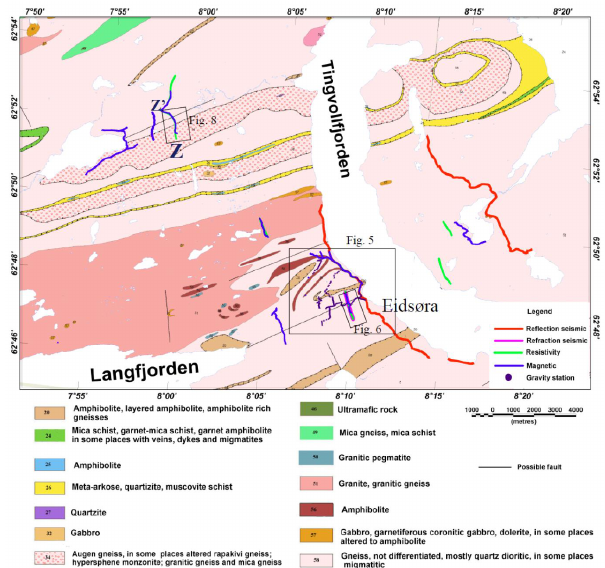
Fig. 2. Simplified bedrock map of the study area (after Tveten et al., 1998). The respective locations of the different geophysical profiles are shown. The black boxes outline some of the geophysical profiles shown in Figs. 5, 6 and